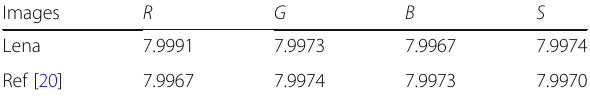
Table 6 Information entropy of encryption image Images